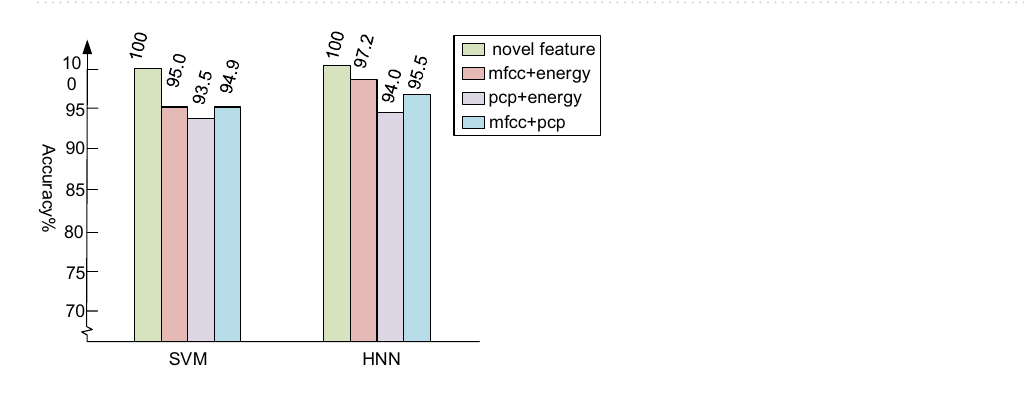
Figure 4. Structure of the hybrid neural network classifier.